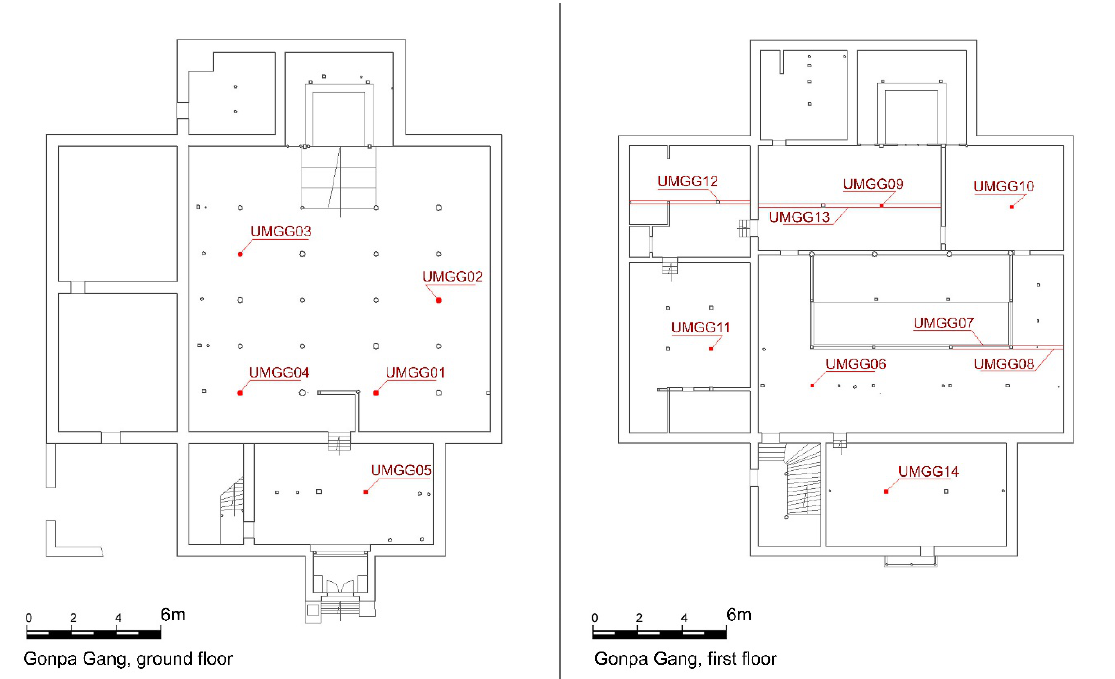
Figure 7. Plans of the ground floor and the first floor of the gönpa. The sampled elements are marked in red and labeled.